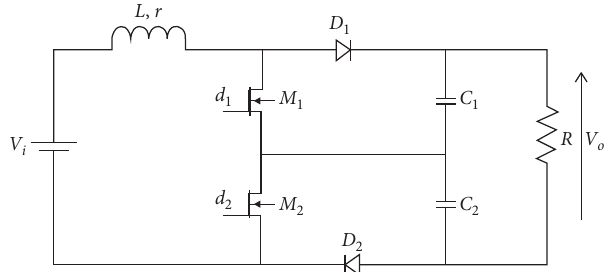
Figure 1: Three-level boost converter